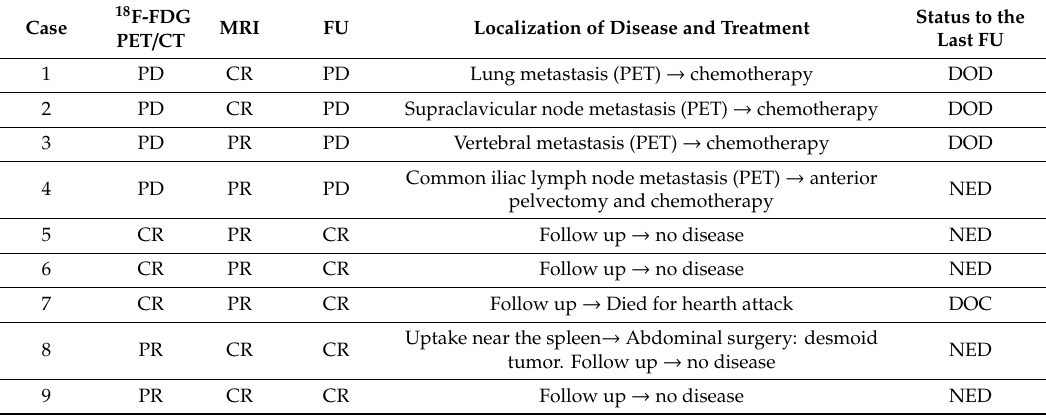
Table 3. Details of discordant cases.